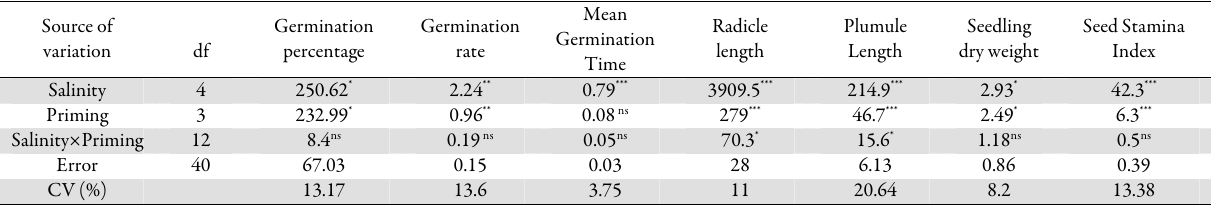
Source of variation